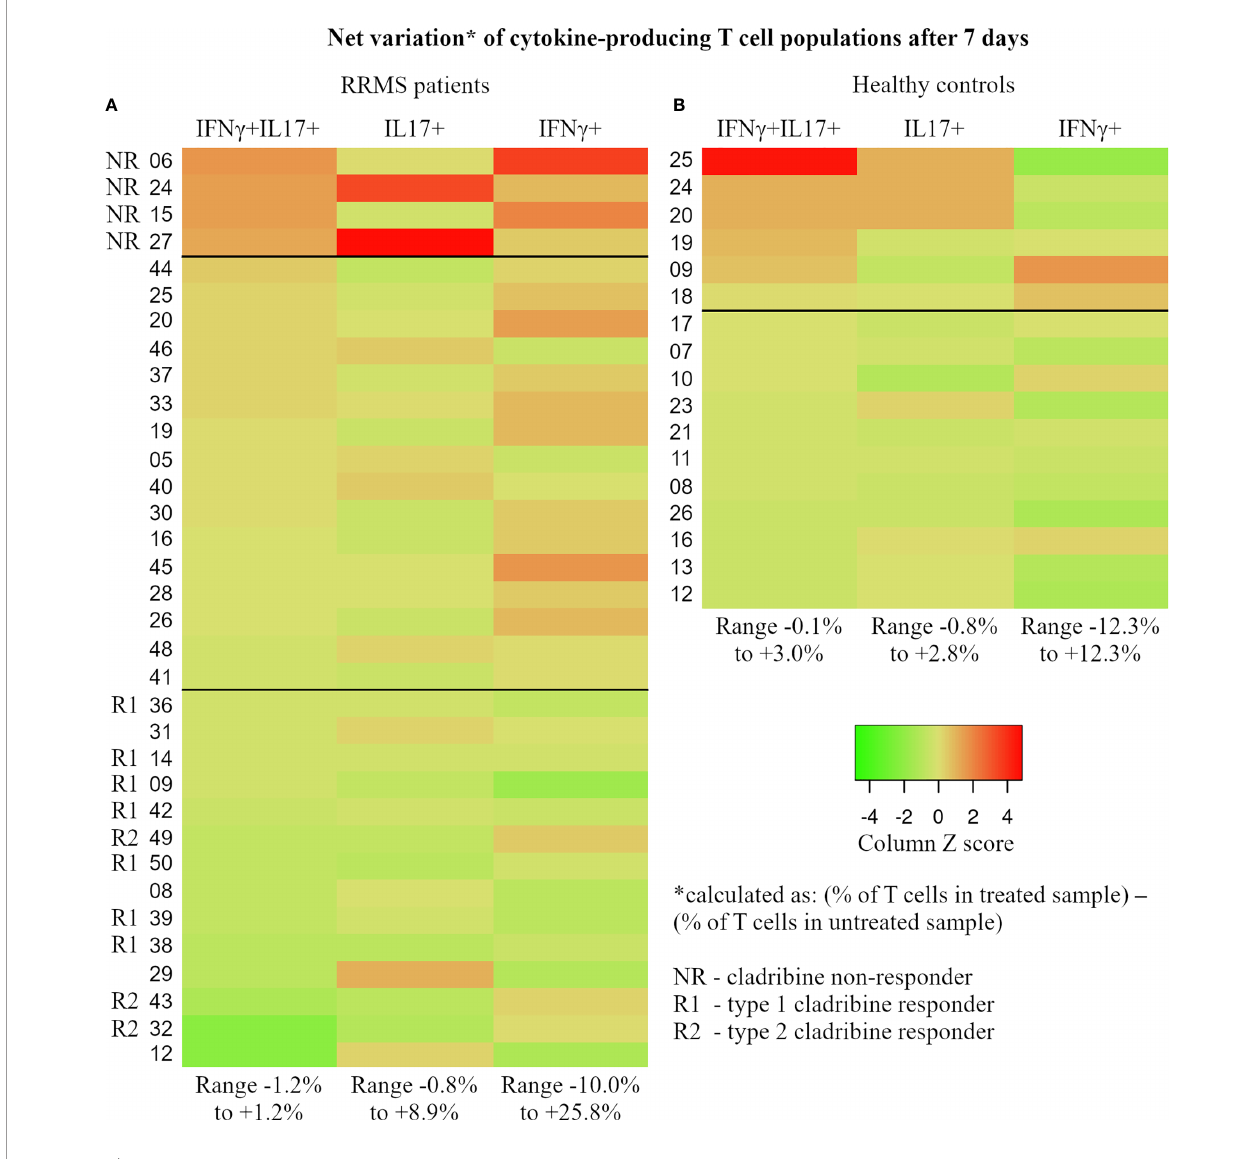
FIGURE 11 | For each subject, the percentage of IFN g +IL17+, IL17+, and IFN g + T cells was determined at day 7 through fl ow cytometry from paired cladribine- exposed and unexposed samples. The net effect of cladribine on the cytokine-producing populations was calculated for each subject as follows: (cytokine-producing population as % of T cells in the cladribine-exposed sample) – (the same cytokine-producing population as % of T cells in the unexposed sample). Calculated values re fl ect the true effect of cladribine and were used to generate the 2 heatmaps in this fi gure ( A – RRMS patients, B – healthy donors). Based on the observed trends and patterns, RRMS patients were divided into 3 groups that may re fl ect each subject ’ s individual reaction to cladribine exposure: NR, non-responders (de fi ned as net increase in all 3 cytokine-producing T cell populations after cladribine exposure), R1 – type 1 responders (de fi ned as net decrease of all three cytokine-producing T cell populations), and R2 – type 2 responder (de fi ned as net decrease of IFN g +IL17+ and IL17+ T cells combined with net increase in IFN g + T cells). Note that HC and RRMS share the same color gradient. Also, the values are color coded based on Z score, while the range of absolute net % values for cell populations is presented at the bottom of each